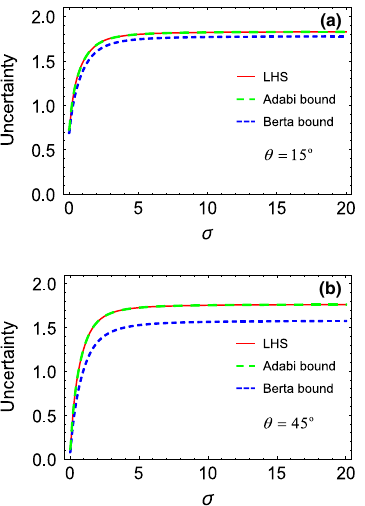
Fig. 4 The LHS, Adabi bound, and Berta bound with respect to the expansionrapidity σ whenconsideringtwocomplementaryobservables